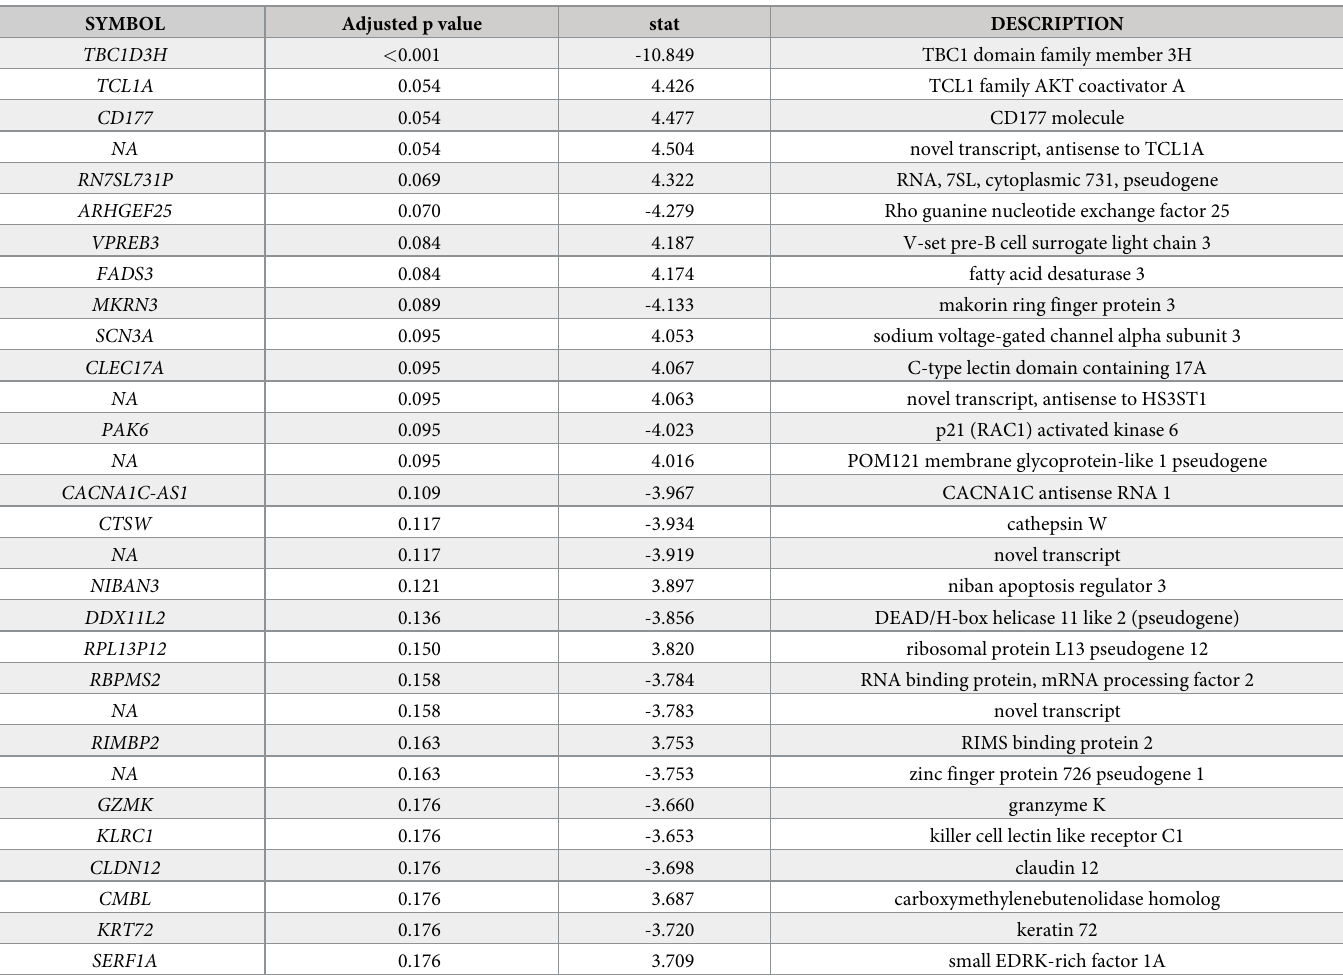
Table 2. Top 30 differentially expressed genes in those who did vs. did not develop NTM-PD.